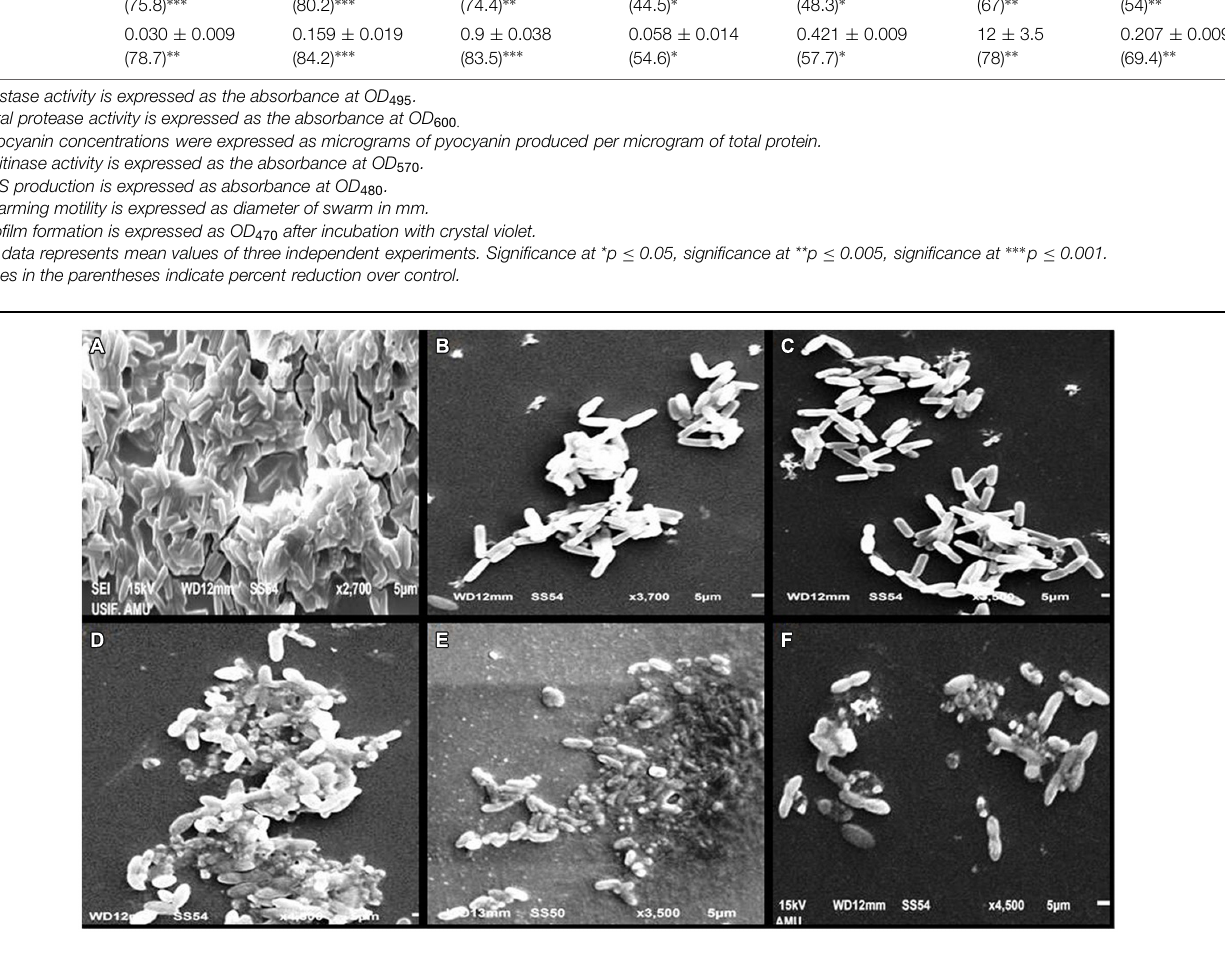
as in the ligand-complexed crystal structure. This docked